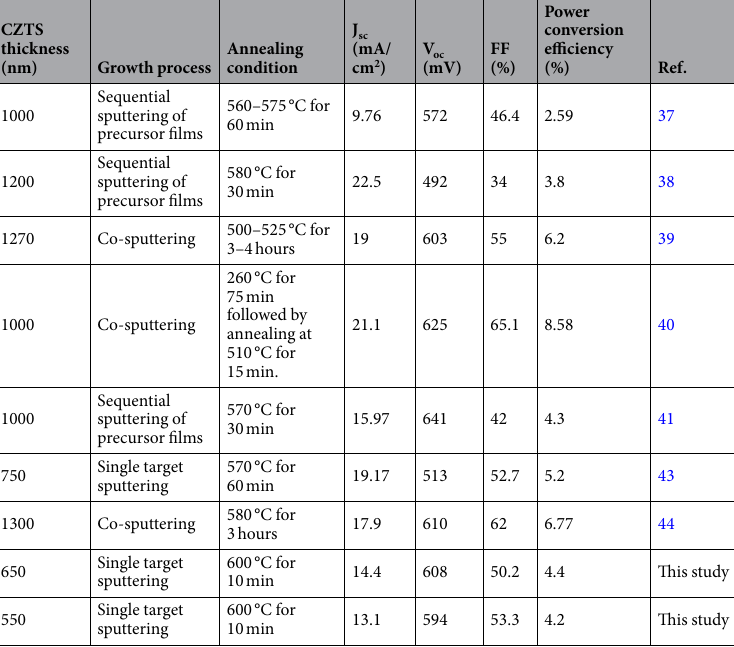
position can be tuned in-situ during sputter deposition 50–53 . We believe that optimization of Mo content into the CZTS layer and control thickness of interfacial layer for thick CZTS layer can boost cell efficiency further.